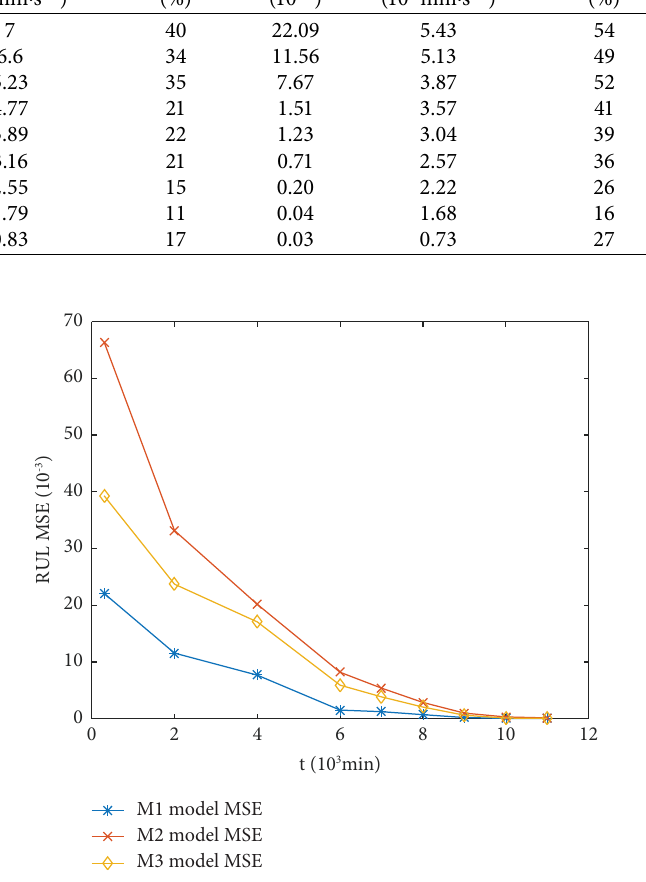
Figure 9: RUL MSE